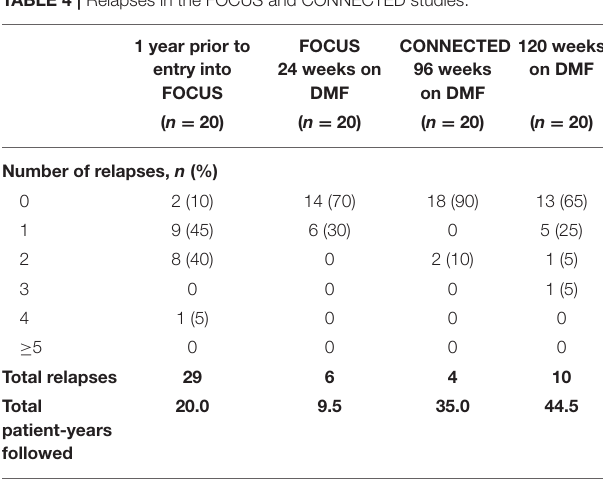
TABLE 4 | Relapses in the FOCUS and CONNECTED